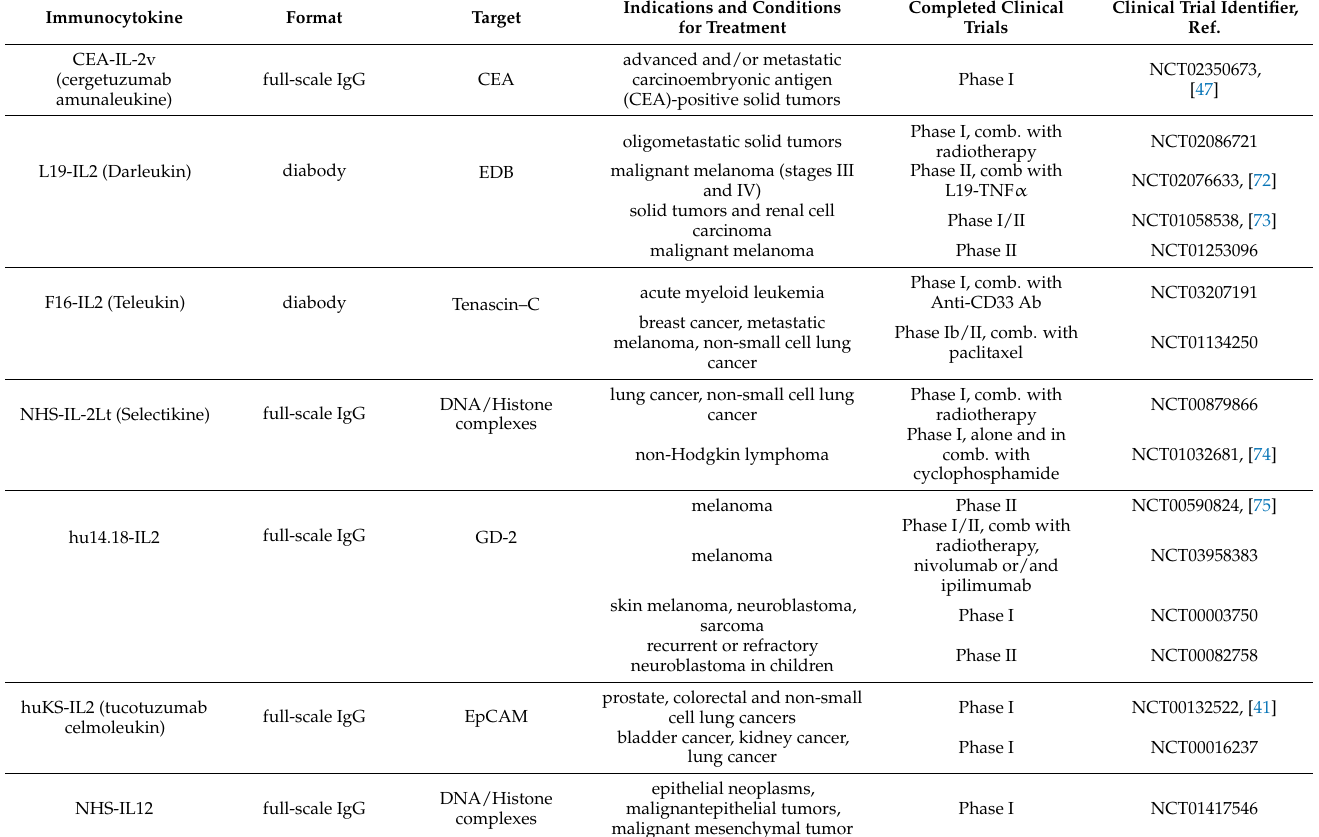
Table 1. Immunocytokines for cancer treatment in clinical development. Fibronectin splice-isoforms and DNA/Histone complexes are the most frequent targets for the delivery of cytokines. IL-2-, IL-12-, and TNF- α -based immunocytokines are investigated in clinical